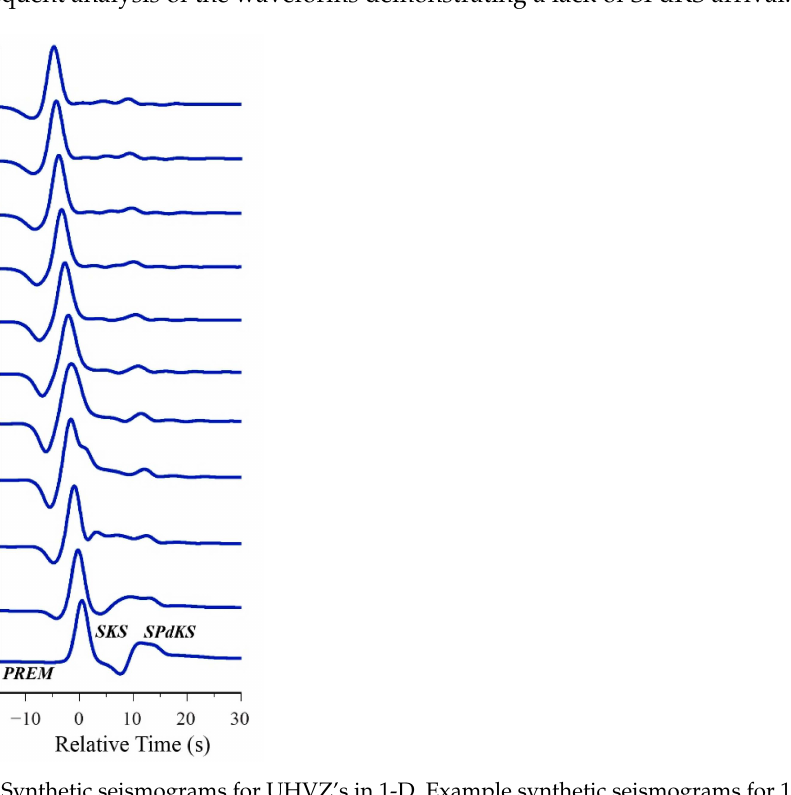
Figure 4. Synthetic seismograms for UHVZ’s in 1-D. Example synthetic seismograms for 1-D UHVZ models. Radial component displacement seismograms are shown. Predictions are aligned in time on the PREM predicted SKS arrival time and arranged in order of UHVZ strength. The PREM synthetic is shown at strength = 0. Models shown all have UHVZ thickness of 50 km. From the bottom to the top, δ V S and δ V P increase in 5% increments. For example, the first few models are: Strength 500 (h = 50 km; δ V S = δ V P = +5%), Strength 1000 (h = 50 km; δ V S = δ V P = +10%), etc. All synthetics shown are computed for an epicentral distance of ∆ = 120 ◦